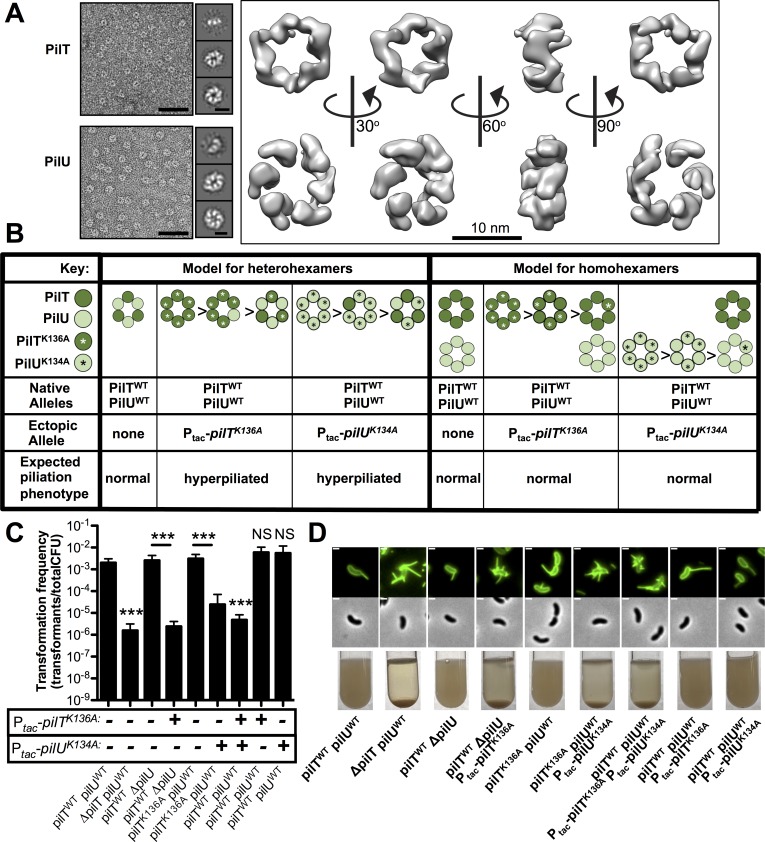
PilT and PilU form independent homomeric complexes in vitro and in vivo to facilitate pilus retraction.(A) Representative negative stain transmission electron micrographs of purified 6XHis-PilT and 6XHis-PilU (left; scale bar, 50 nm). 2D class averages revealing hexameric rings (middle; scale bar, 10 nm) and 3D reconstructions (right) of the ring complex. (B) Schematic of the experimental approach and expected outcomes for testing whether PilT and PilU form homomeric or heteromeric complexes to facilitate pilus retraction in vivo. (C) Natural transformation assays of indicated strains incubated with 500 ng of tDNA and after 7 minutes, DNAseI was added to prevent additional DNA uptake. The genotype of native pilT and pilU alleles are written below each bar graph and the presence or absence of a chromosomally-integrated IPTG-inducible ectopic allele of pilTK136A or pilUK134A is indicated by a + or -. Strains were grown with 100 μM IPTG if they contained an ectopic expression construct. Data are shown as the mean ± SD and are from four independent biological replicates. (D) Representative images of surface piliation (top) and aggregation phenotypes (bottom) for the indicated strains. Scale bar, 1 μm. Asterisk(s) directly above bars denote comparisons to the parent strain. All comparisons were made by one-way ANOVA with Tukey’s post test. NS, not significant; *** = P < 0.001.